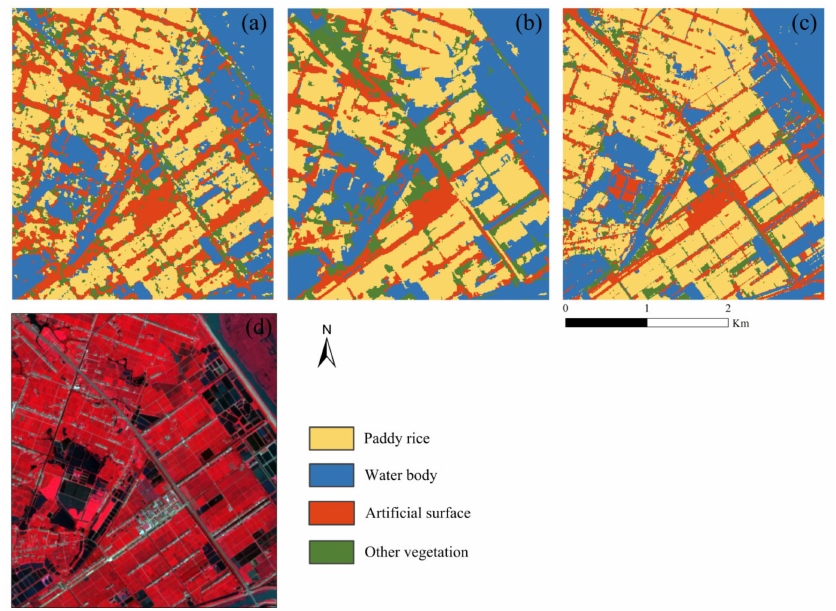
Figure 10. Comparison of rice mapping results using different classification strategies based on SVM and the 2019 dataset: ( a – c ) represent the partial result under PSI, SOI and POI; ( d ) represents the false color image of Sentinel-2 (Red: Band8, Green: Band4, Blue: